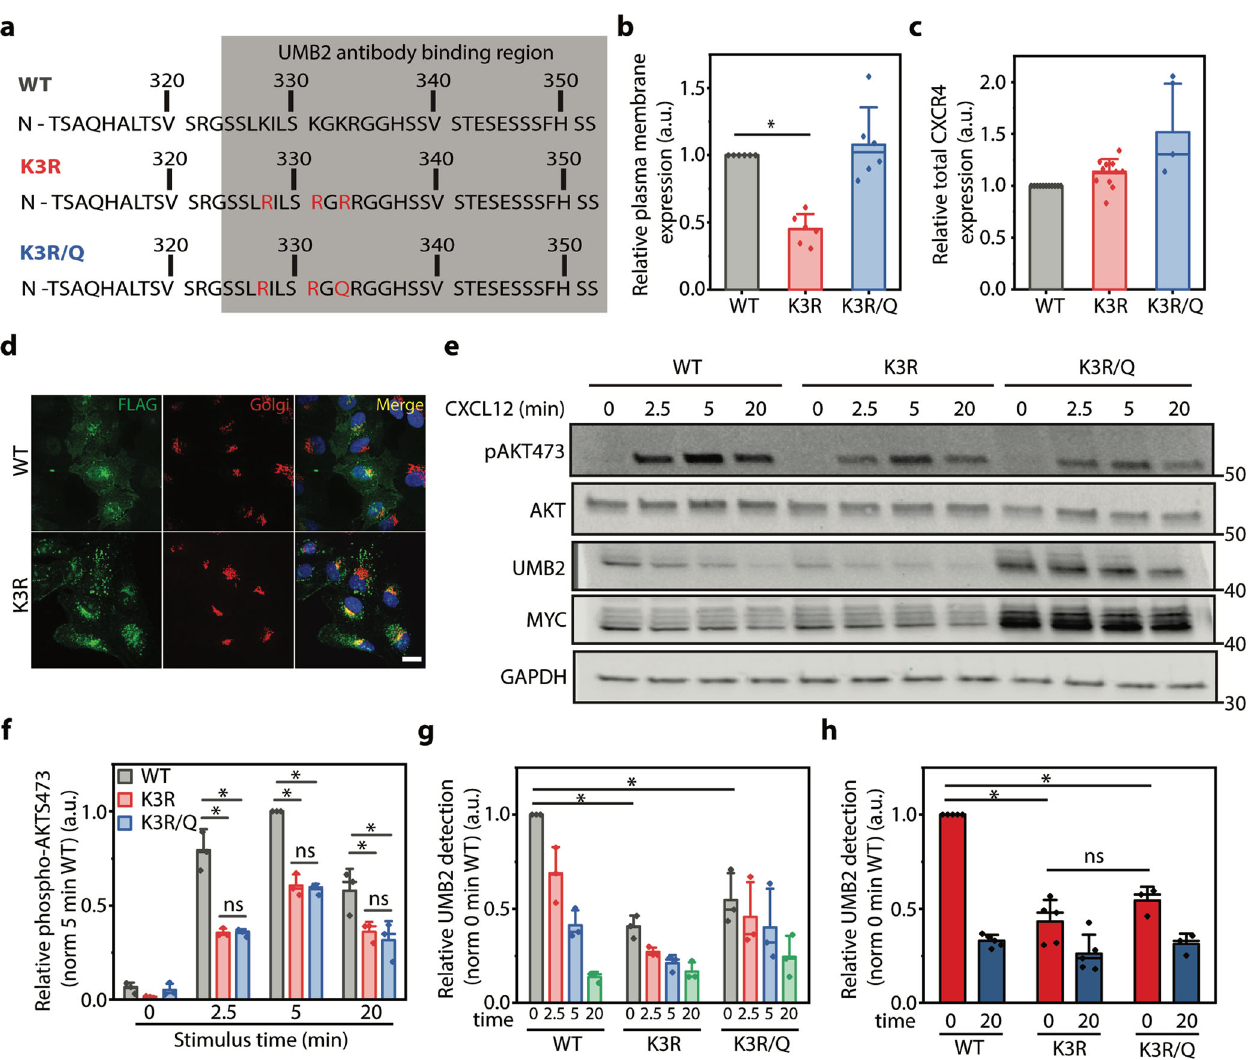
Fig. 1 CXCL12-depedent AKT S473 phosphorylation and CXCR4 PTM are independent of CXCR4 localization. a Illustration of CXCR4 mutant receptor constructs. The gray box denotes the binding region of the UMB2 antibody that is sensitive to CXCR4 PTM. b Flow cytometry analysis of overexpressed WT and mutant receptor plasma membrane localization in RPE cells. Data were normalized to total receptor and WT plasma membrane expression. c Flow cytometry analysis of WT and mutant receptor total expression. Individual data points were normalized to WT CXCR4 expression. d Representative microscopy images illustrating the distribution of WT and K3R CXCR4 localization within RPE cells overexpressing each construct. CXCR4 was labeled with a FLAG antibody and the Golgi was detected using a GM130 antibody. Scale bar is 10 μ m. Images were captured using 60× magni fi cation on a spinning disk confocal microscope. e Representative western blot illustrating CXCL12-induced (12.5 nM) AKT S473 phosphorylation and CXCR4 PTM for WT and mutant receptors. Total CXCR4 was detected using a MYC antibody and unmodi fi ed CXCR4 by UMB2. f Western blot quanti fi cation of AKT S473 phosphorylation for WT and mutant CXCR4. Relative AKT phosphorylation was calculated by normalizing phospho-AKT to total AKT band intensity, and secondly to the 5 min control time point. g Western blot quanti fi cation of CXCR4 PTM (i.e., UMB2 detection). A decrease in UMB2 detection is correlated to increased CXCR4 PTM. CXCR4 PTM was calculated by dividing the UMB2 intensity by the MYC intensity (total CXCR4) and secondly to the 0 min time point for the WT receptor. h Flow cytometry analysis of agonist-dependent WT and mutant CXCR4 PTM. Relative UMB2 detection was determined by dividing median UMB2 detection by total CXCR4 fl uorescence and normalized to 0 min WT CXCR4. All experiments were conducted a minimum of three times in RPE cells overexpressing WT or mutant CXCR4. Individual data points from each experiment are plotted; mean, standard deviation (SD), and median line. Statistical signi fi cance * p < 0.05. Example of fl ow cytometry gating strategy is shown in Supplementary Fig. 6. Complete raw blots are shown in Supplementary Fig.